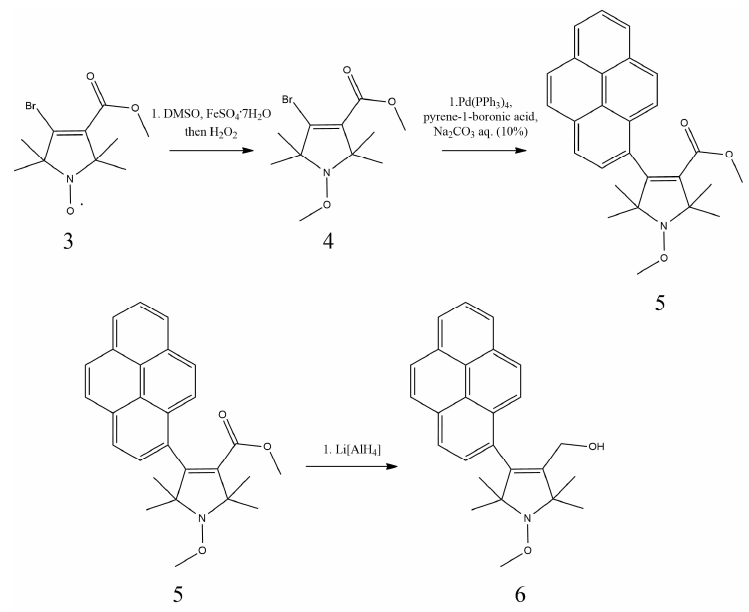
Figure 4. Synthesis route of the OMe derivative compound 6.